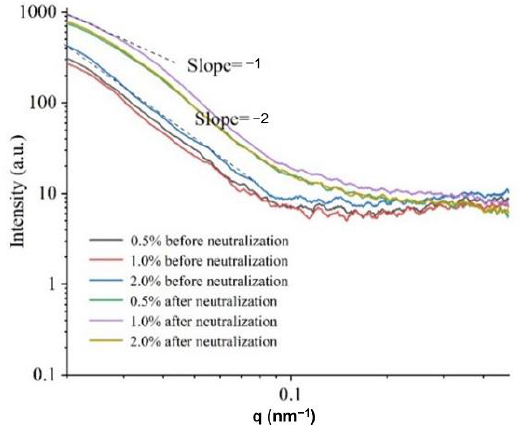
Figure 5. Effects of chitosan concentration on crystals of films before and after neutralization.